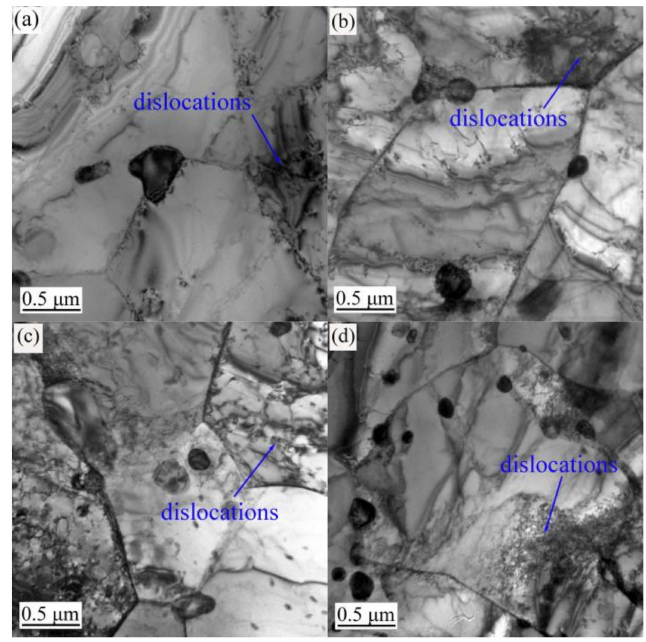
Figure 3. Transmission electron microscopy (TEM) observations of the annealed AISI 420 steel after proton radiation with di ff erent cumulative charges ( a ) 0 p / cm 2 ; ( b ) 2 × 10 14 p / cm 2 ; ( c ) 2 × 10 15 p / cm 2 ; ( d ) 2 × 10 16 p / cm 2